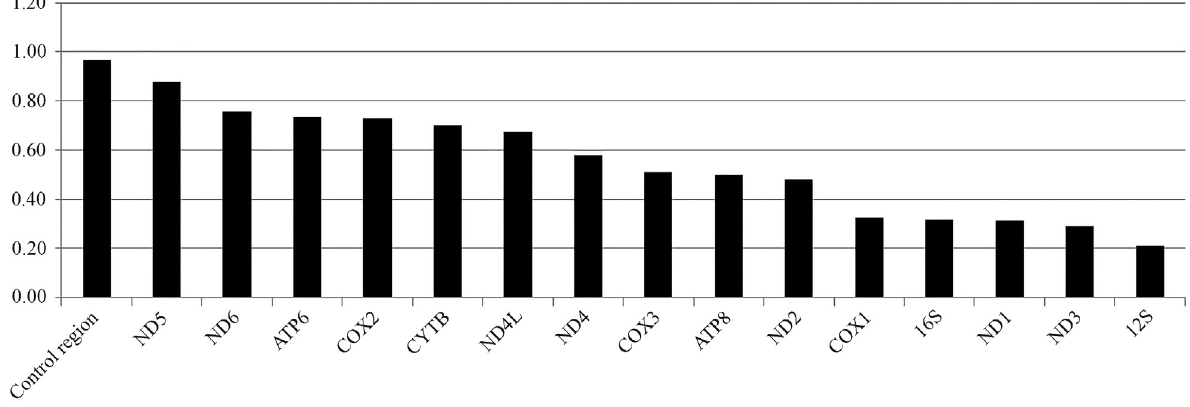
Figure 2 - Percentage of variation per lo cus obtained by comparison of the complete mitogenome sequences of M. gouazoubira described here with that previously described from Colombia (GenBank acession number